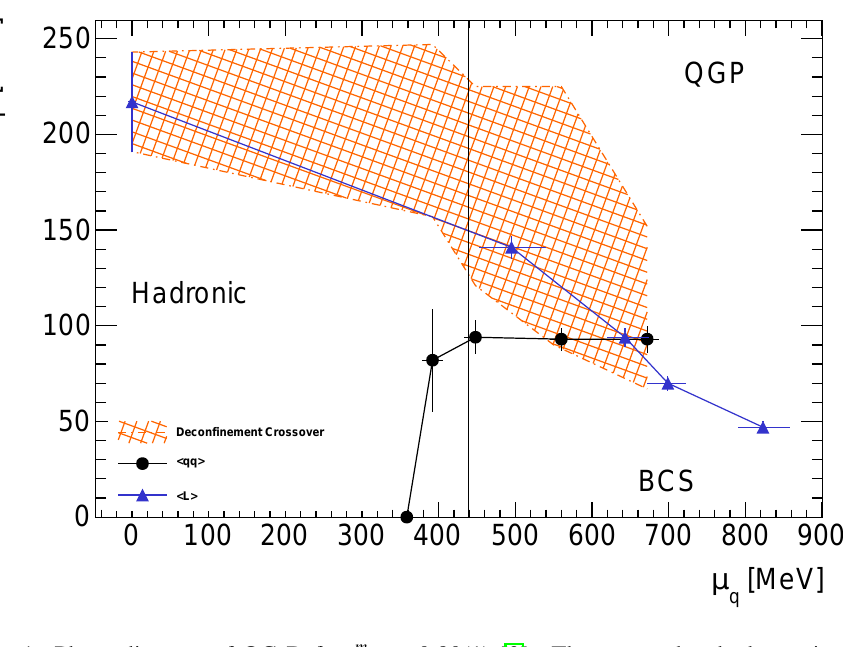
= 0 . 80(1) [2]. The orange hatched area is the Figure 1: Phase diagram of QC 2 D for m π m ρ deconfinement crossover region, black circles correspond to the superfluid transition and the blue triangles the inflexion point of the Polyakov loop from